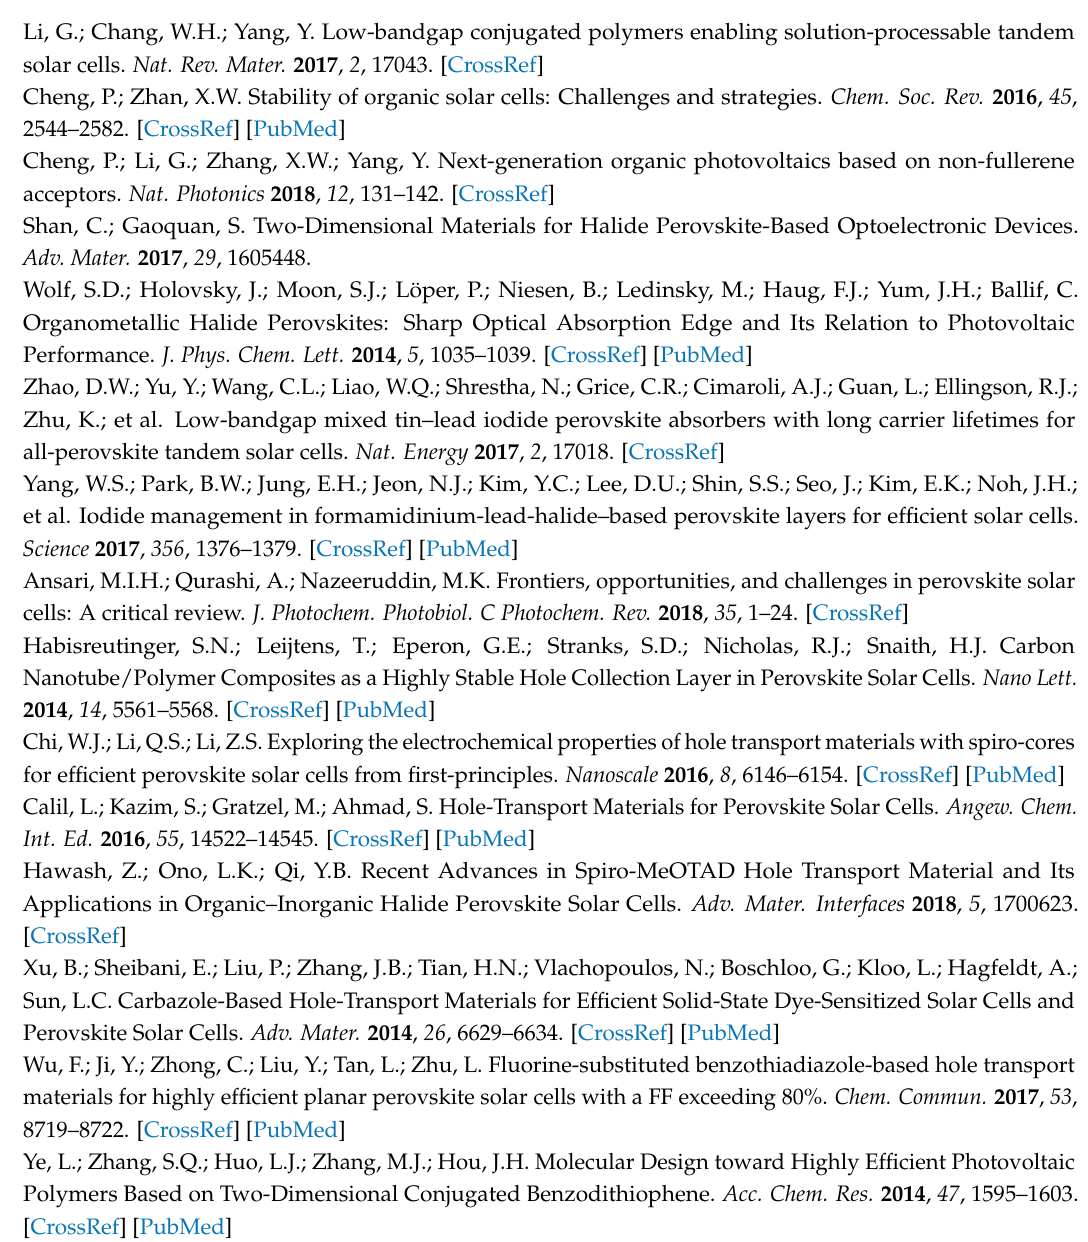
Figure S1: Working principle of PeSCs, where the perovskite layer sandwiched by an electron transfer materials (ETM) and a hole transfer materials (HTM) as a whole is placed between a transparent electrode (FTO) and a metal electrode